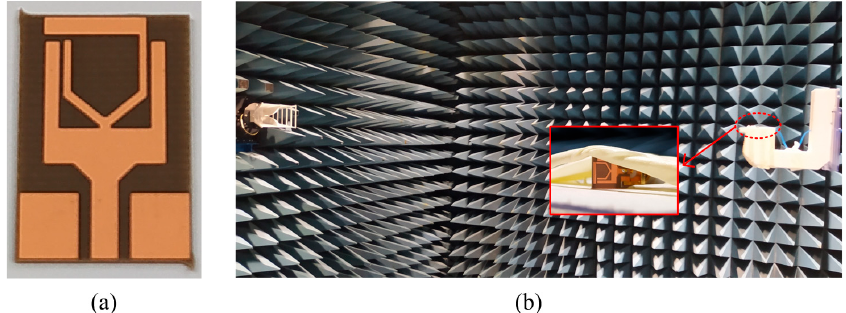
Figure 4. Proposed extended UWB antenna’s ( a ) prototype and ( b ) antenna under test.